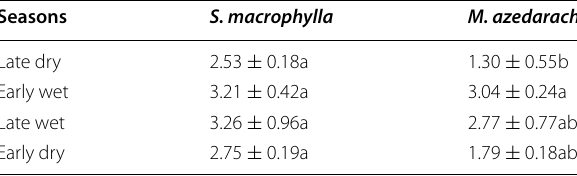
Means followed by different lowercase letters differ significantly between seasons at P <